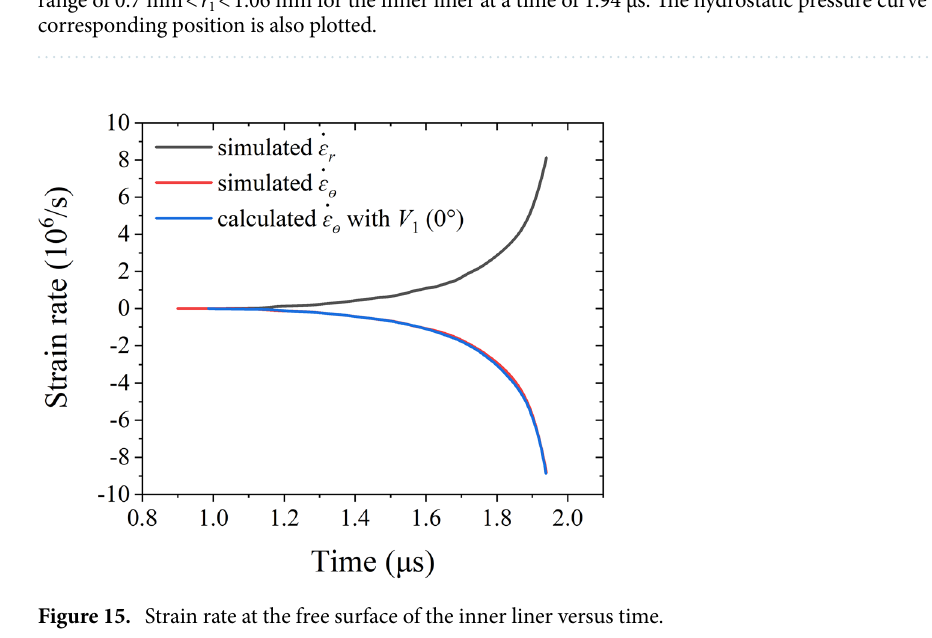
Figure 14. Simulated temperature, isentropic temperature, and adiabatic temperature 40 curv es spanning the